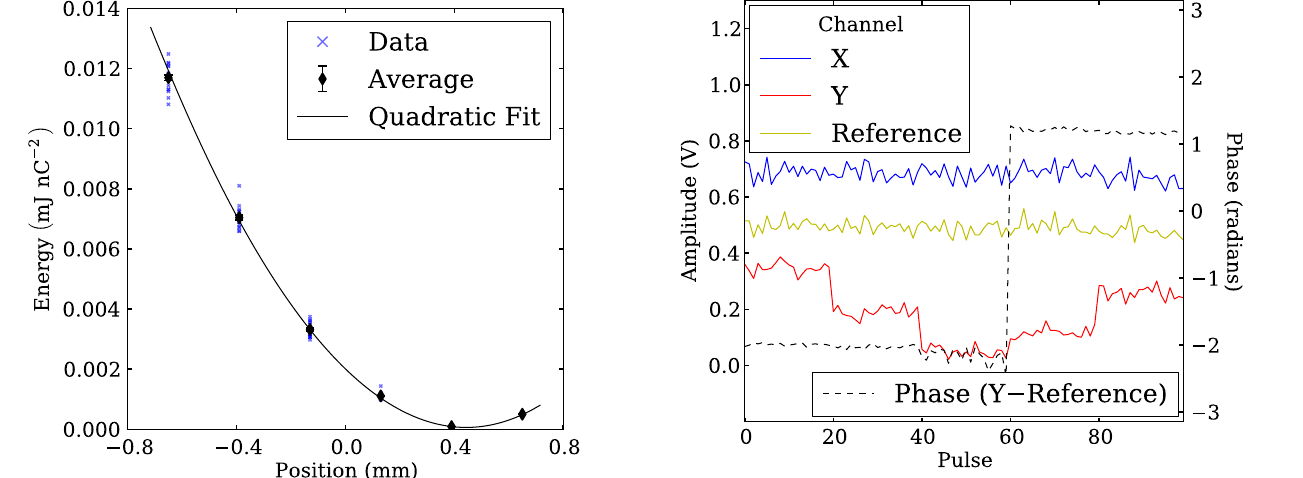
FIG. 12. Total signal energy from the horizontal position cavity channel normalized by bunch charge squared during a sweep in the horizontal beam position.